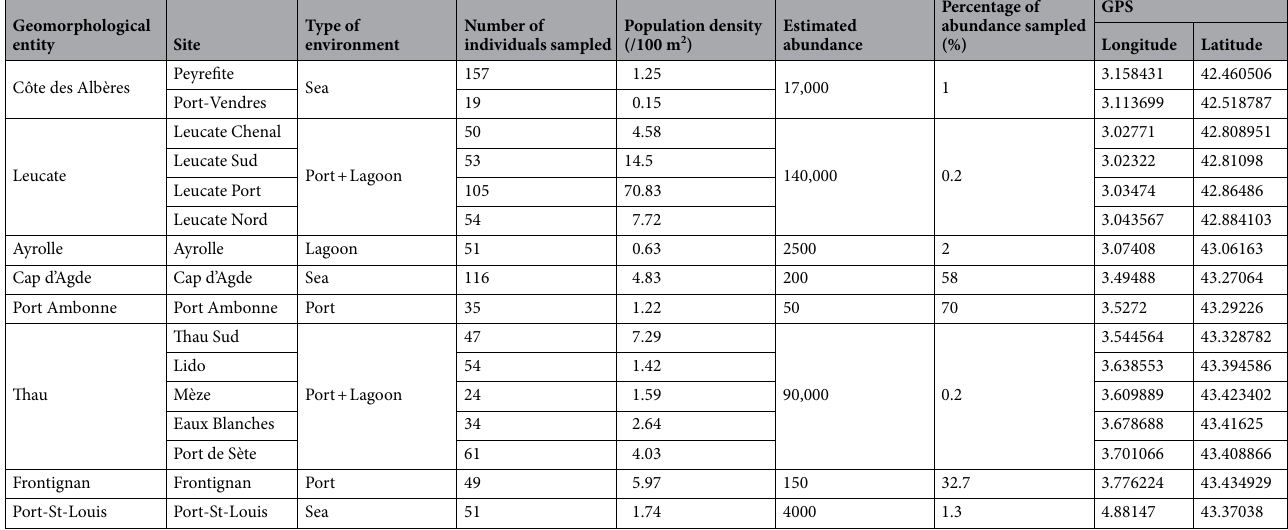
Table 1. Collection information for the 16 sampling sites in the Gulf of Lion (north-western Mediterranean Sea) where the 960 Pinna nobilis individuals were collected for this